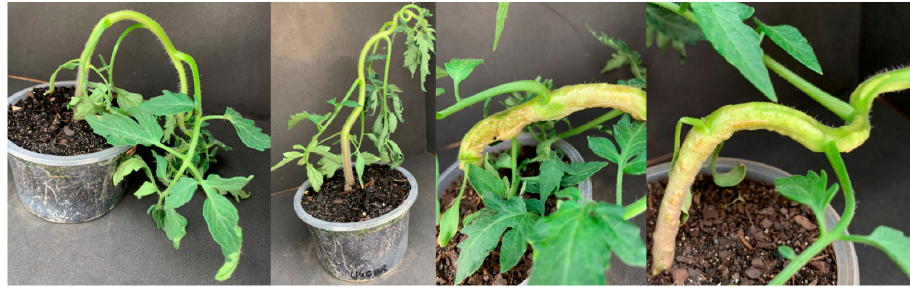
Figure 2. The effects of simulated 2,4-D drift with a close-up view show injuries in tomato plants.